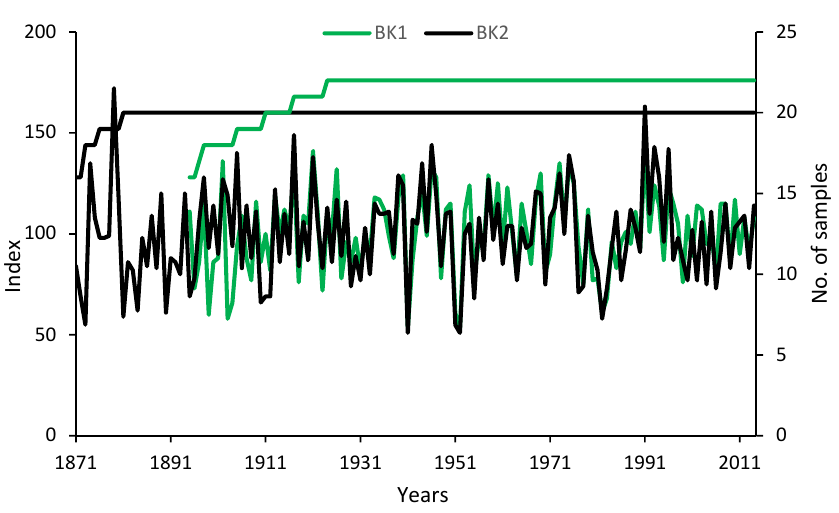
Figure 3. Comparison of Pinus sylvestris residual chronologies from Bagno Kusowo. Table 1. Selected statistics of measured and indexed Pinus sylvestris chronologies. STD = standard deviation; MS = mean sensitivity; A1 = 1st-order autocorrelation; RBar = average correlation between trees for the common overlap period among series; EPS = expressed population signal. Lab.